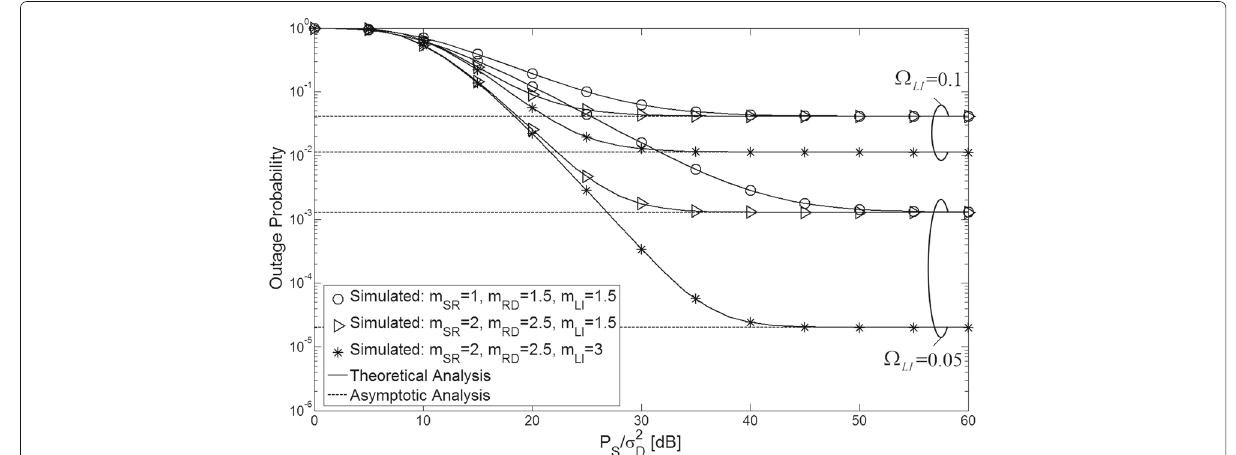
Fig. 2 Outage probability of the fixed-gain AF-FD systems for (cid:6) LI = { 0.05,0.1 } , γ th = 3 and various m values